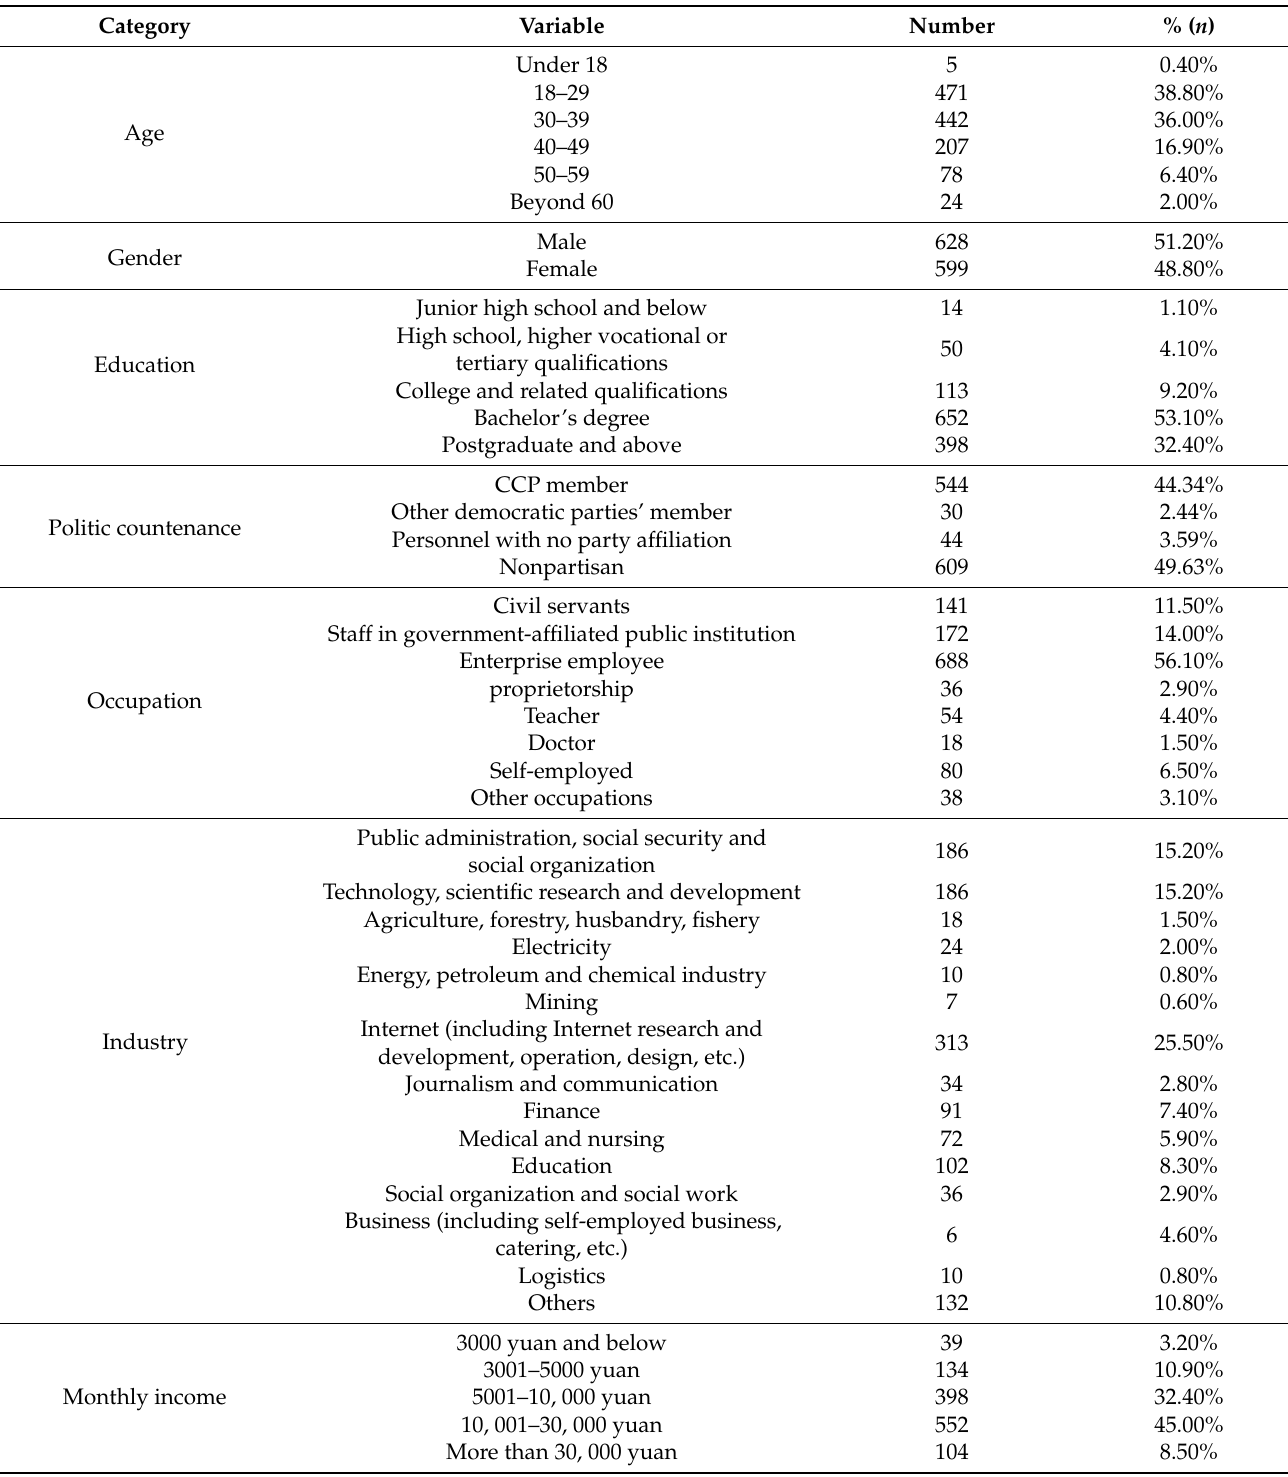
Table 1. Distribution of demographic characteristics of the sample ( n =